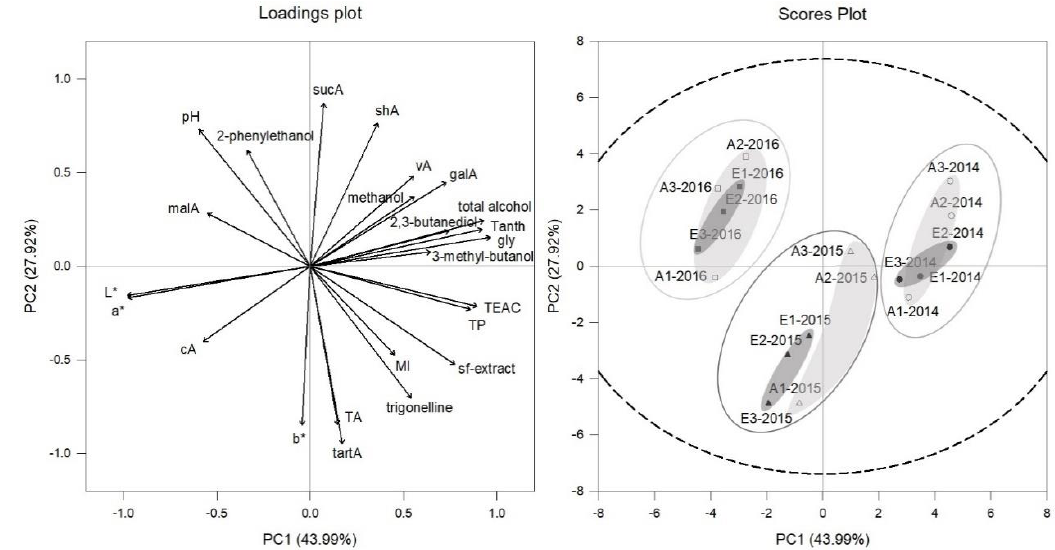
Figure 8. Loadings and scores plot of principal component analysis (PCA) of Cabernet Sauvignon young wines from aCO 2 (open symbols) and eCO 2 (filled symbols) treatment for the years 2014 (circles), 2015 (triangles) and 2016 (squares). Data represent mean values per ring and p = 0.95 for confidence level (dashed line).